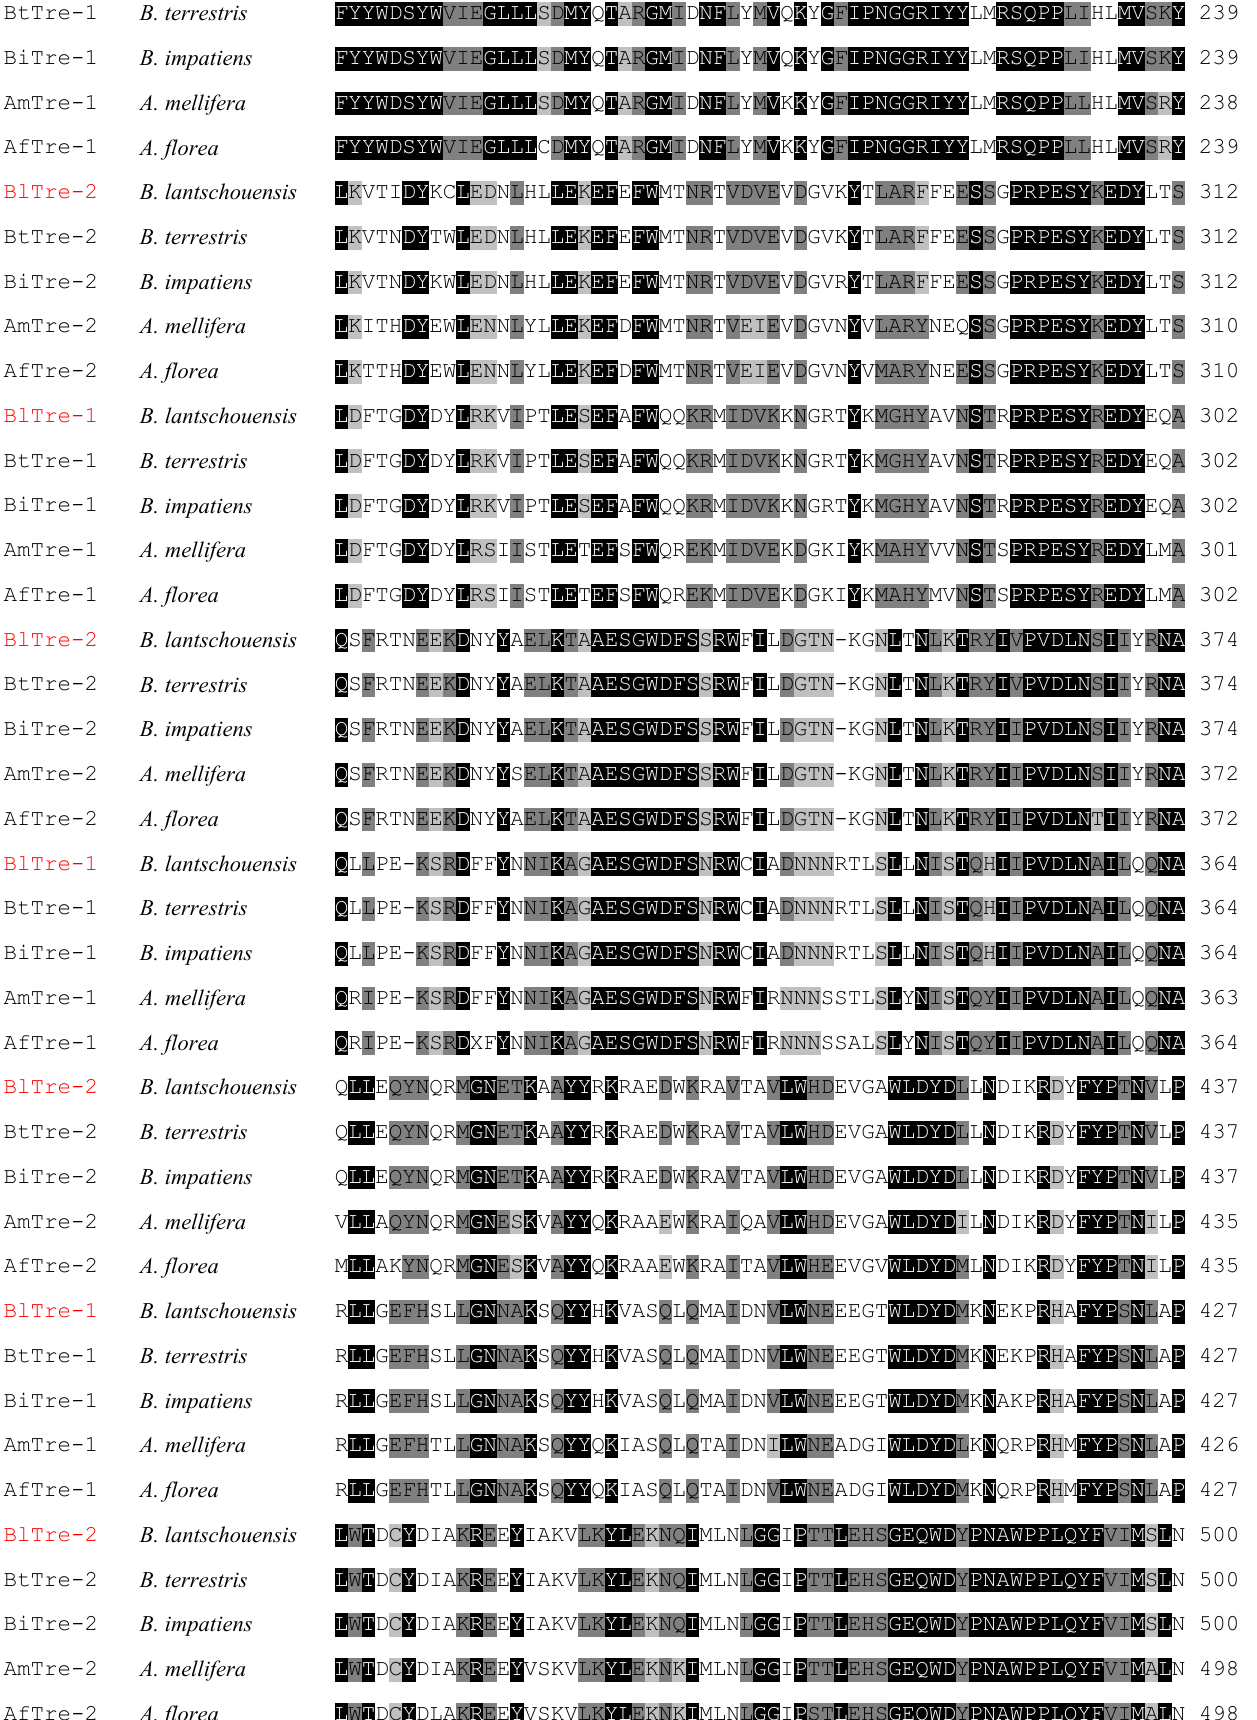
Fig 2 . Comparison of the amino acid sequences of Tre in B. lantschouensis with those in other orthologs.